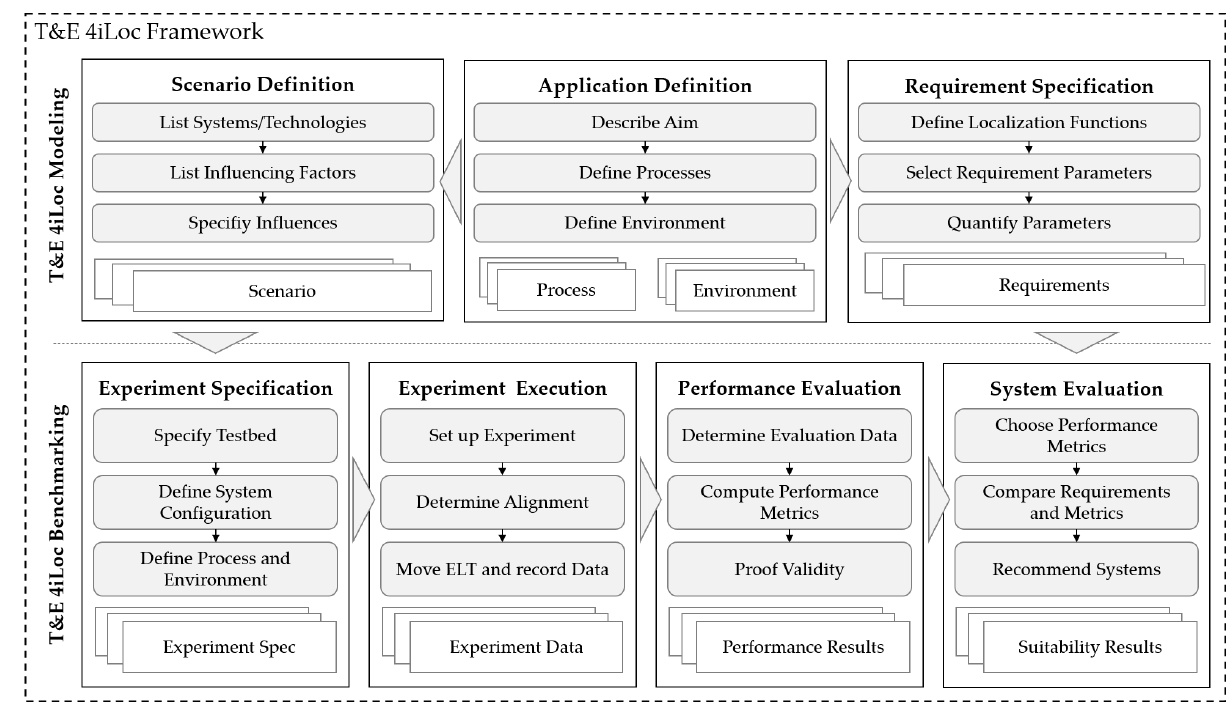
Figure 11. Overview of the T&E 4iLoc Framework , with its modules, functions, and output